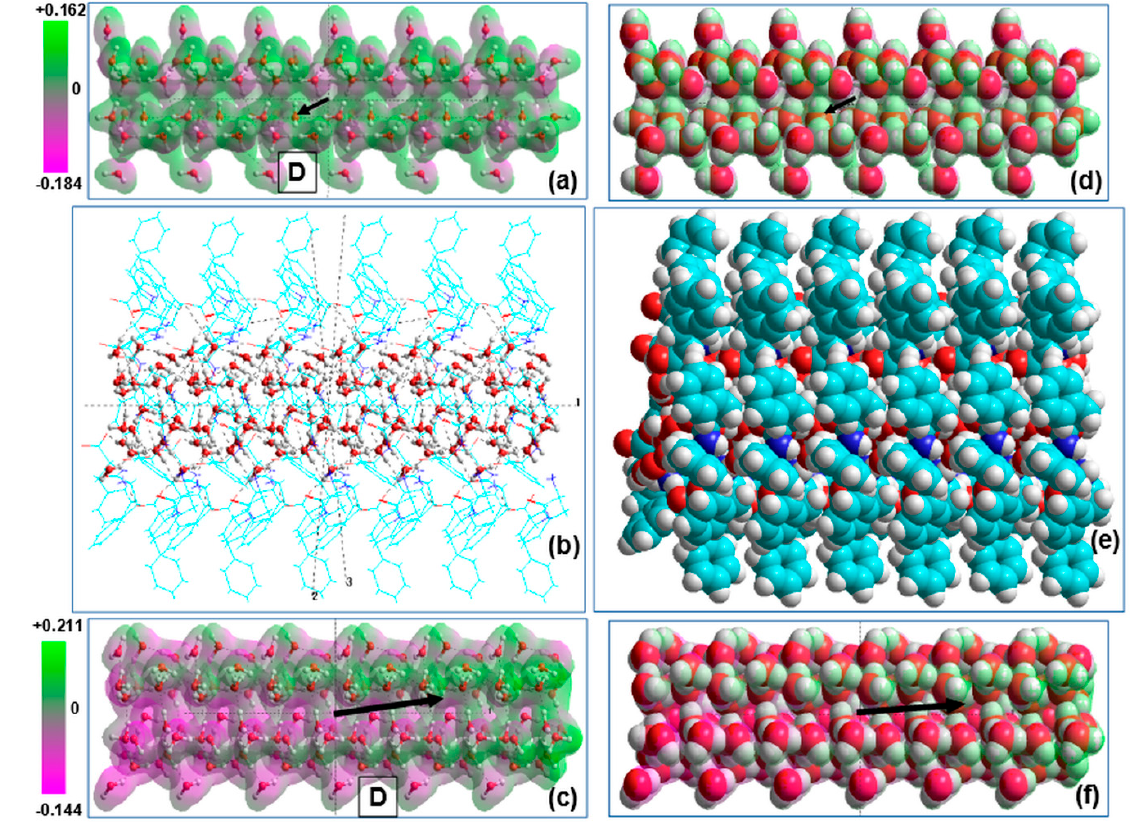
Figure 9. Model images of the water / ice tubular nanostructures and L-FF PNT with filled hydrophilic cavity, consisting from six repeated coils along c-axis (in X-projection): ( a ) initial tubular water / ice structure; ( b ) L-FF PNT with embedded water / ice structures under optimization process; ( c ) water / ice tubular helix structure after optimization inside l-FF PNT; ( d – f ) the same in the VdW surface presentation Vector D show the direction of the total dipole momentum in the initial (D ~1 Debye) and optimized water / ice cluster (D ~97 Debye). Translucent 3D-mapped isosurface on ( a ) and ( c ) (as well as on ( d ) and ( f )) illustrates the re-distribution of the electrostatic potential of water / ice cluster before and after optimization within L-FF PNT. Table 5. Dipole moments and polarization for water / ice cluster after optimization in D-FF and L-FF PNT, consisting from 126 H 2 O molecules (see Figures 8 and 9), computed by various methods. Method Used (In RHF) 126 H 2 O Water / Ice Cluster From after Optimization